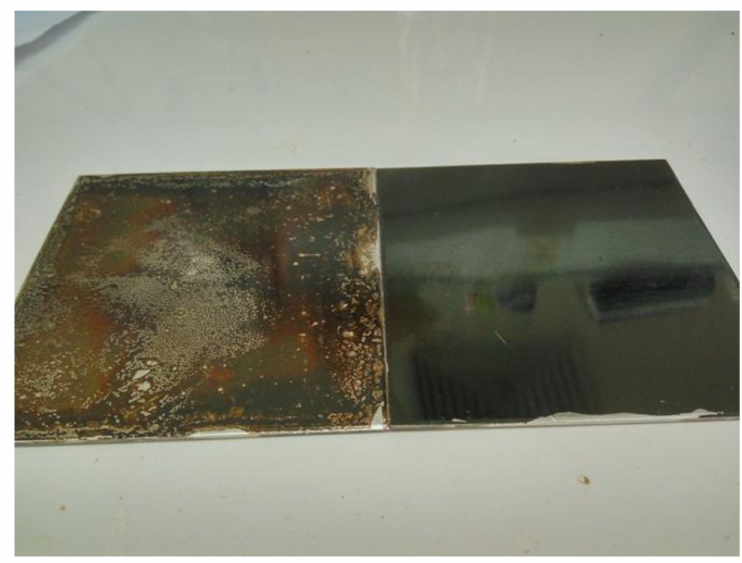
Figure 22. B2 ( left ) and A2 ( right ) NIPU resin surface coatings on stainless steel plates after curing at 300 ◦ C for 3 min.